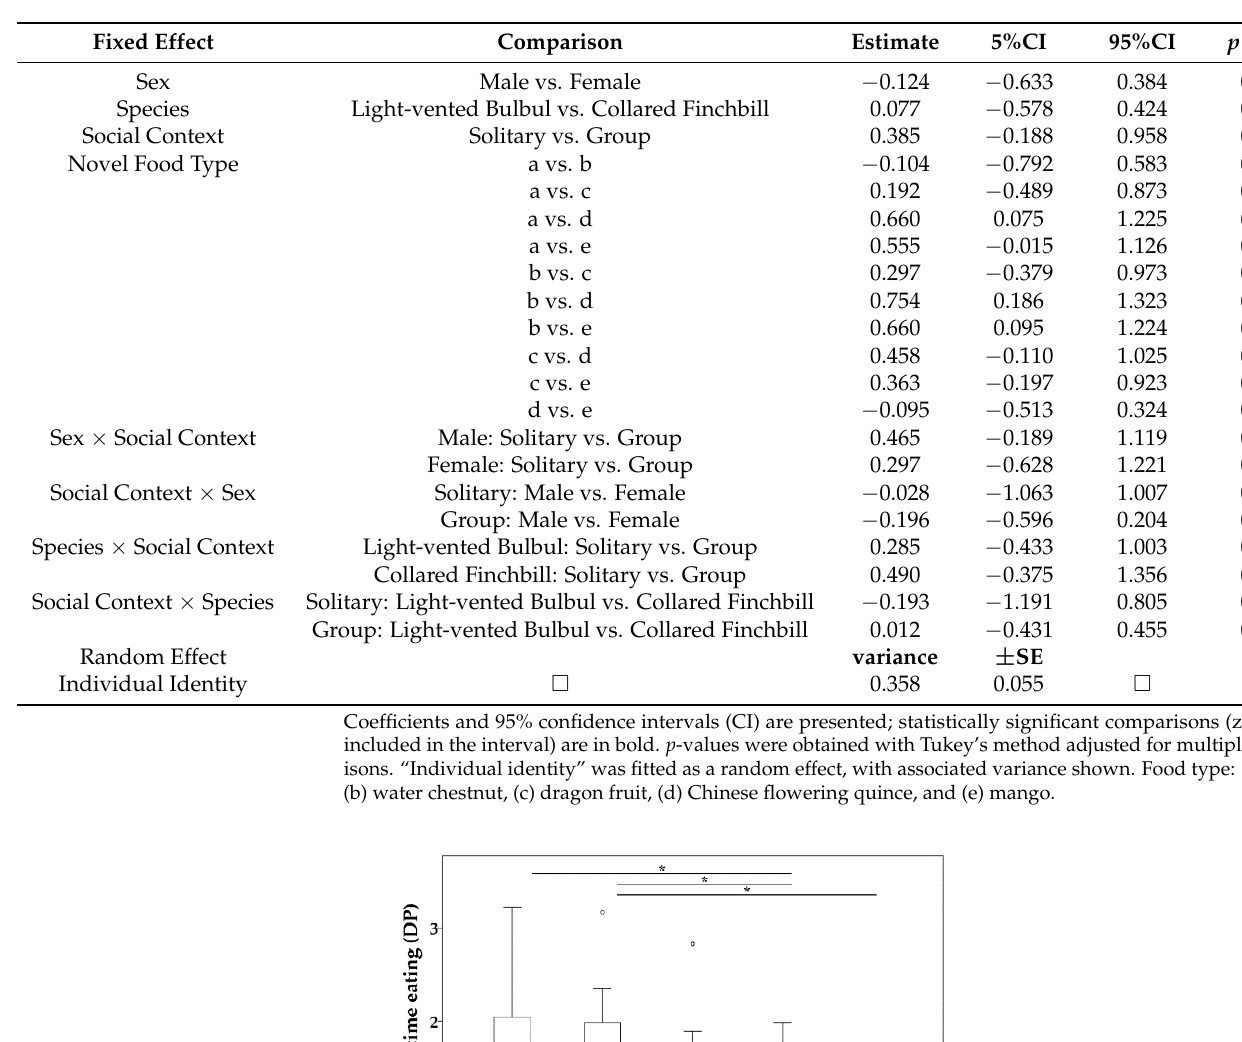
Table 3. Effects of fixed factors on percentage of time eating during 30 min (DP) for solitary and group Light-vented Bulbuls and Collared Finchbills.